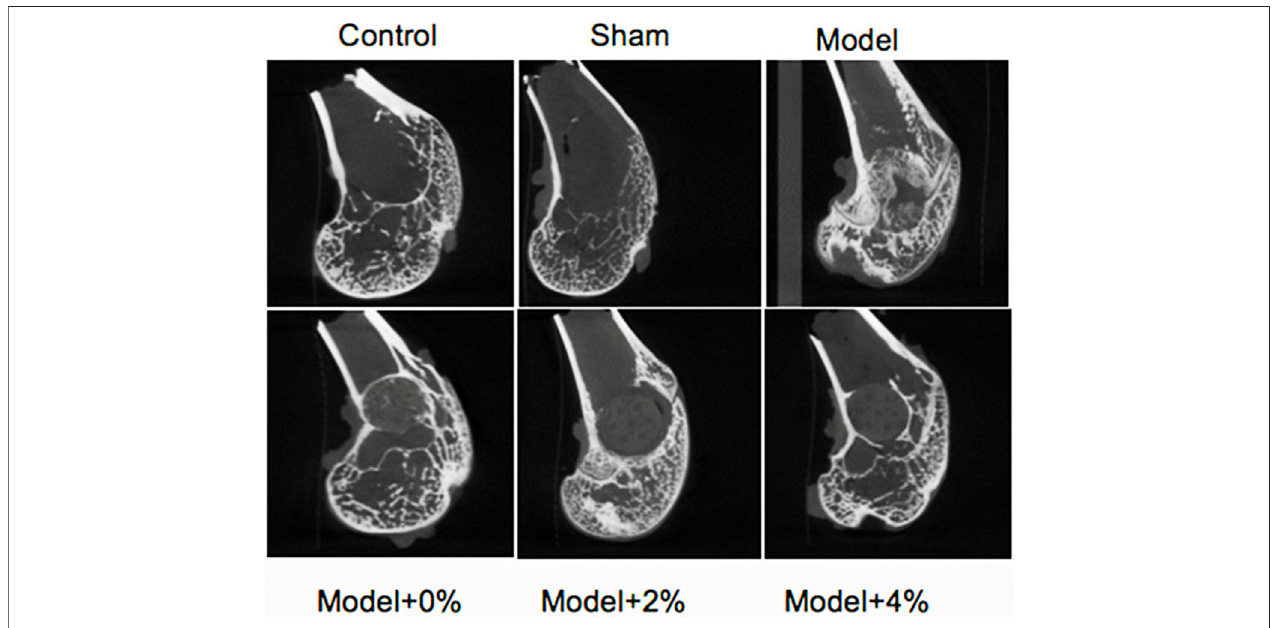
FIGURE 3 | New bone density after 12 weeks as analyzed by micro CT.